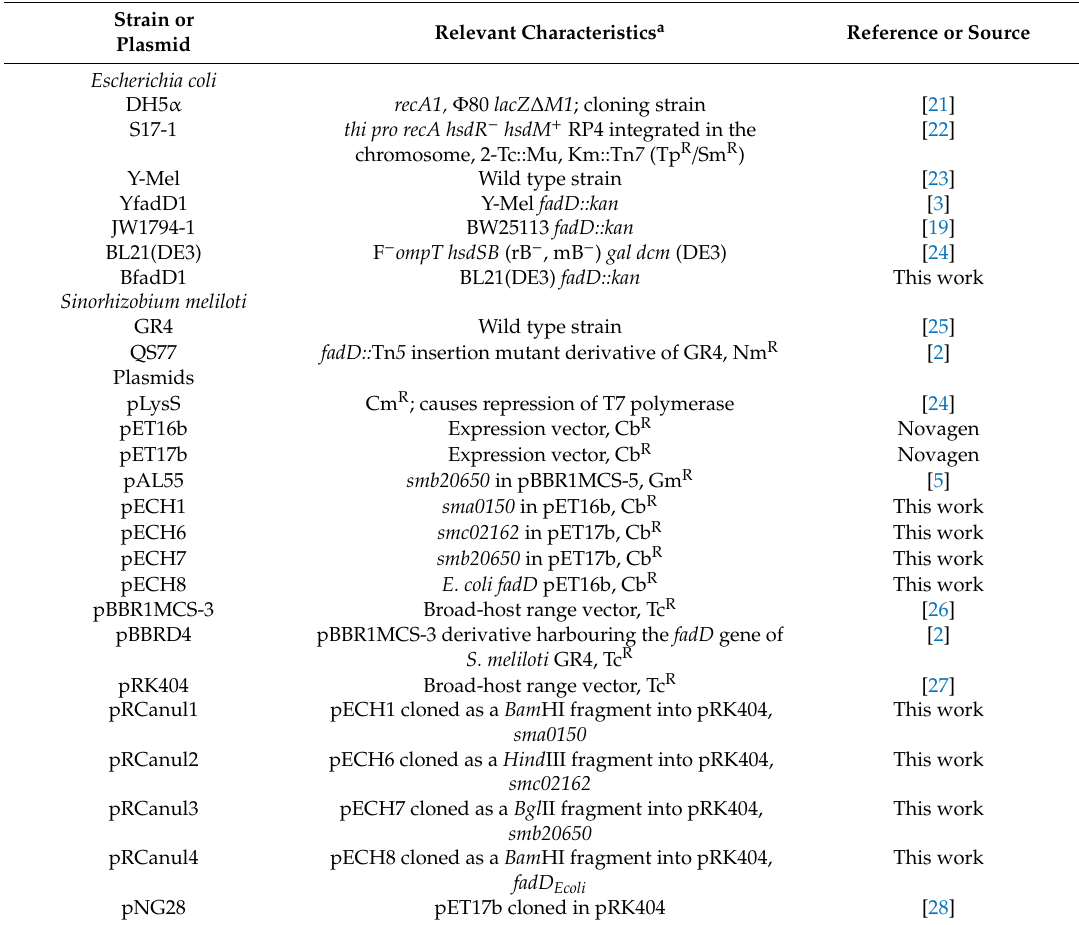
Table 1. Bacterial strains and plasmids used in this